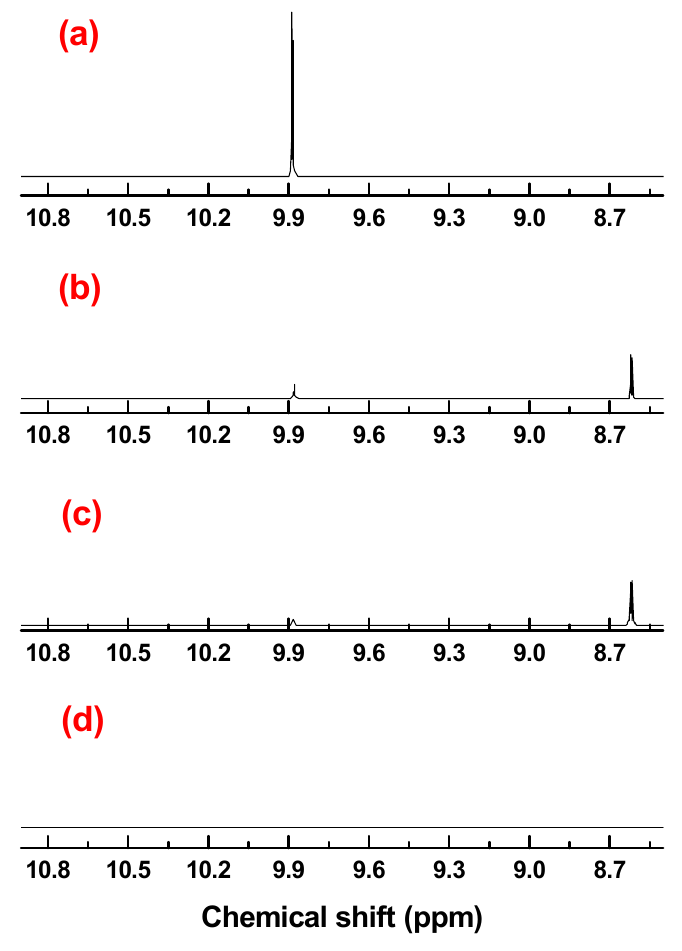
Figure 9. Time-dependent 1 H NMR spectra for Biginelli reaction, formation of 4a . Each spectrum was recorded at regular time intervals: ( a ) 0 min; (b ) 2 min; ( c ) 4 min; ( d ) 6 min.